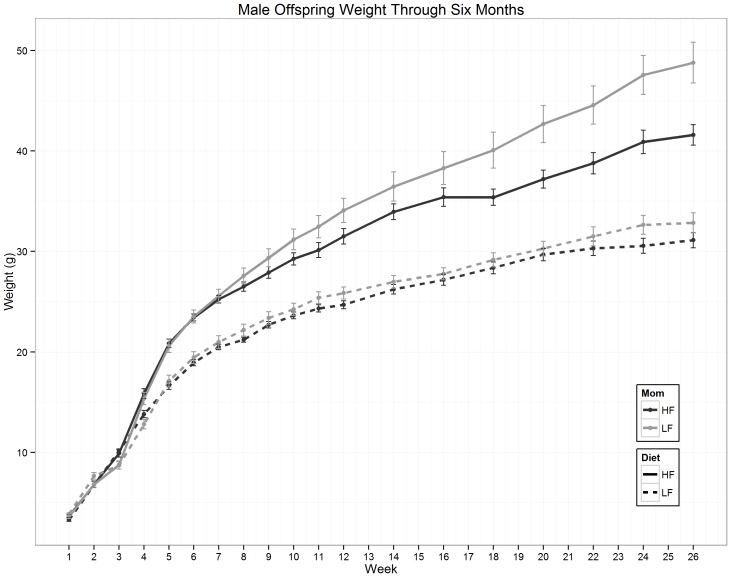
Body weight of male offspring.Average offspring weight (in g, ±SE) is presented from one week through six months of age. Maternal diet is denoted by line color (light gray: LF, black: HF) and adult diet is shown by line style (dashed: LF, solid: HF).